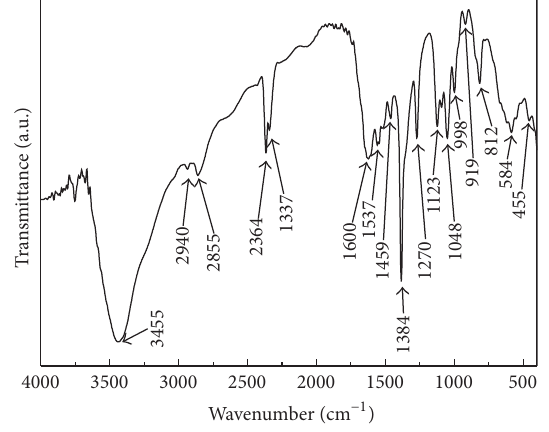
values (the nm 𝐴𝐴 620